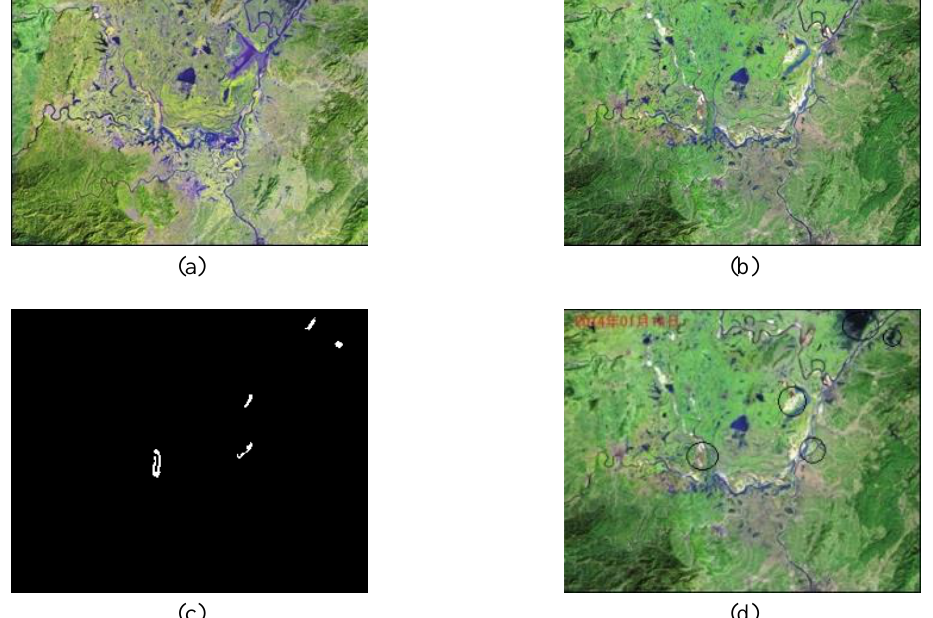
Figure 6. Overall changes under large scale conditions. ( a ) remote sensing images of Dongting Lake from January 1973, ( b ) remote sensing images of Dongting Lake from February 2014, ( c ) the changes in Dongting Lake on a large scale, and ( d ) the region with the greatest change in the